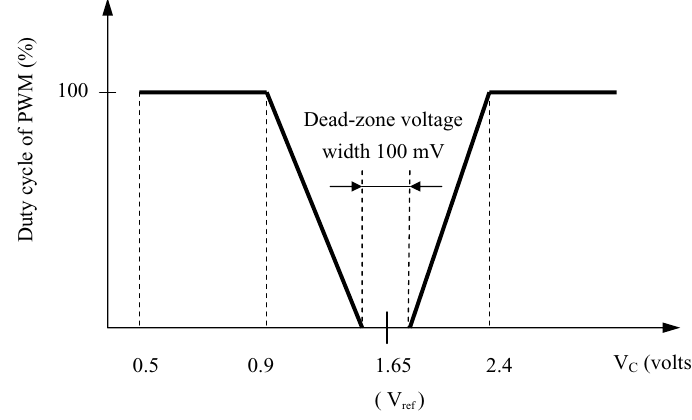
Fig. 5. The duty cycle of PWM signal driven by control signal Vc in